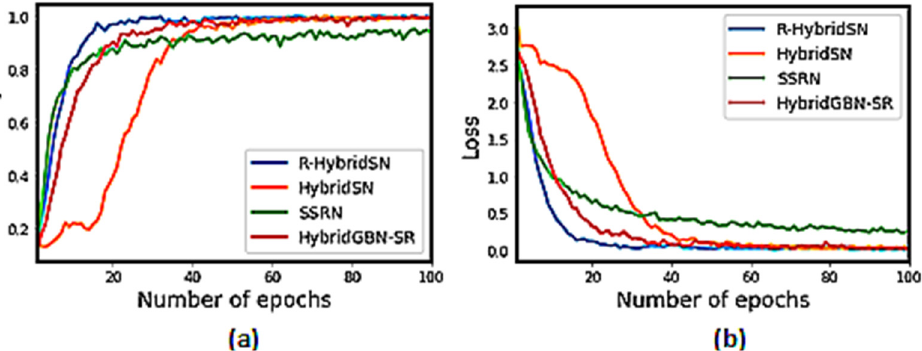
Figure 10. Training graphs for R-HybridSN, HybridSN, SSRN, and HybridGBN-SR for each epoch over IP dataset: ( a ) The training accuracy graph; ( b ) The loss convergence graph.